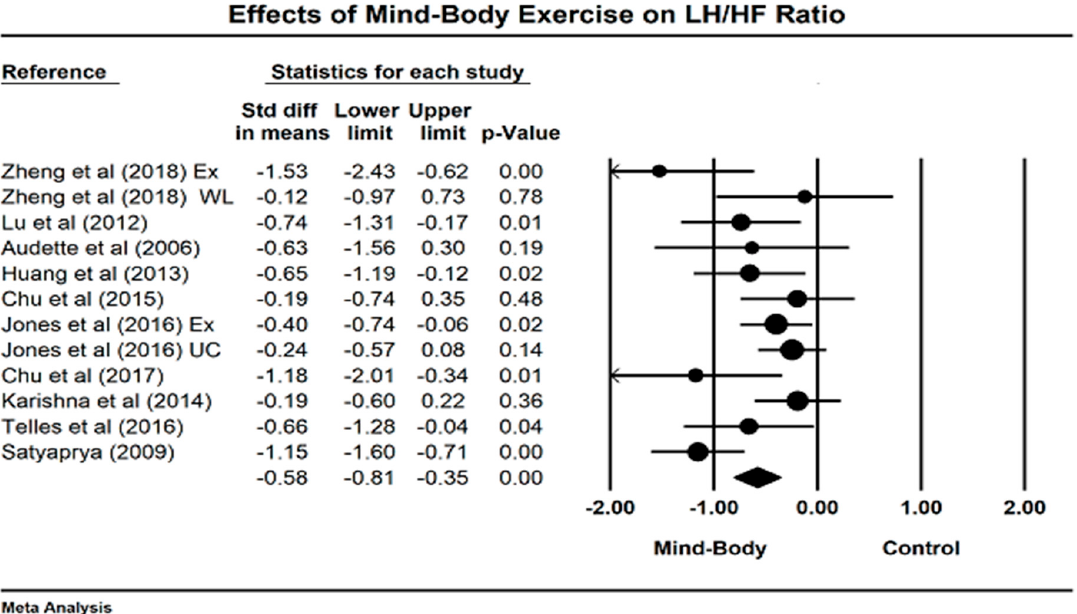
Figure 7. Effects of mind–body exercises on low-frequency to high-frequency ratio (LF/HF ratio = low frequency to high frequency ratio: Ex = Exercise control, WL = waitlist, UC = usual care).